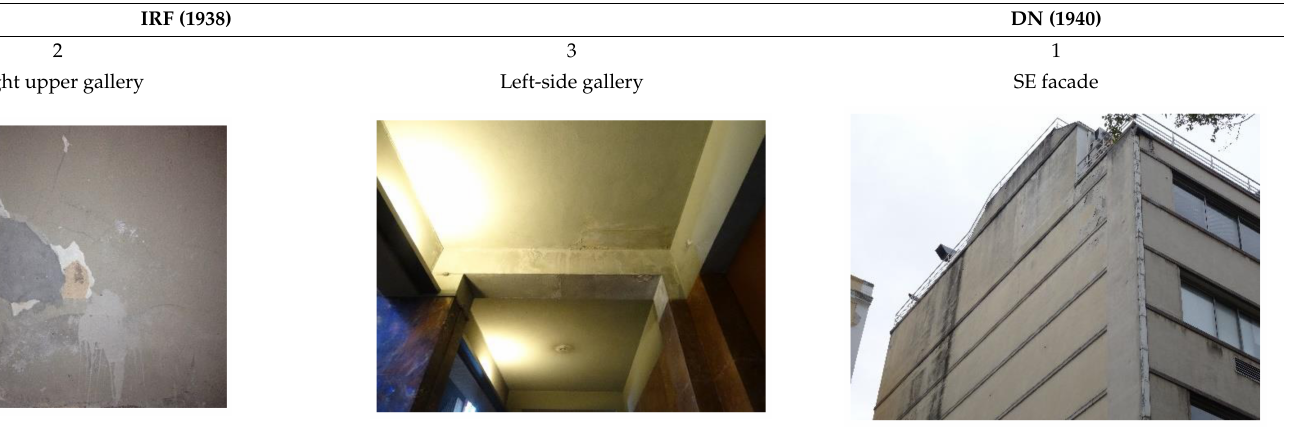
b. Examples of main types of anomalies detected in RCBs’ renders and plasters by